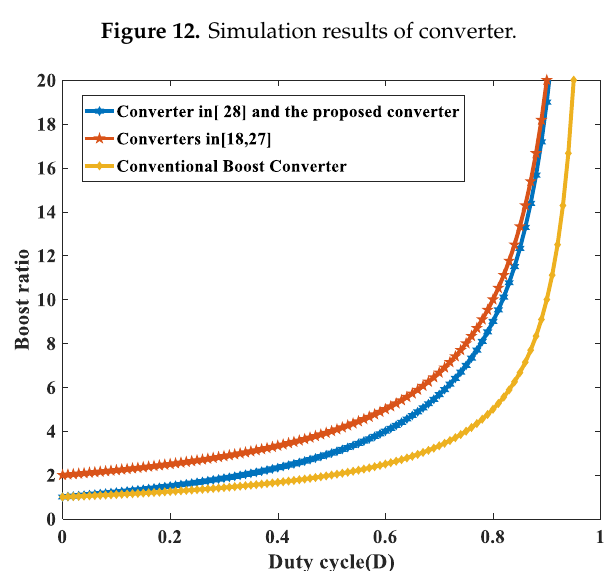
Figure 12. Simulation results of converter.